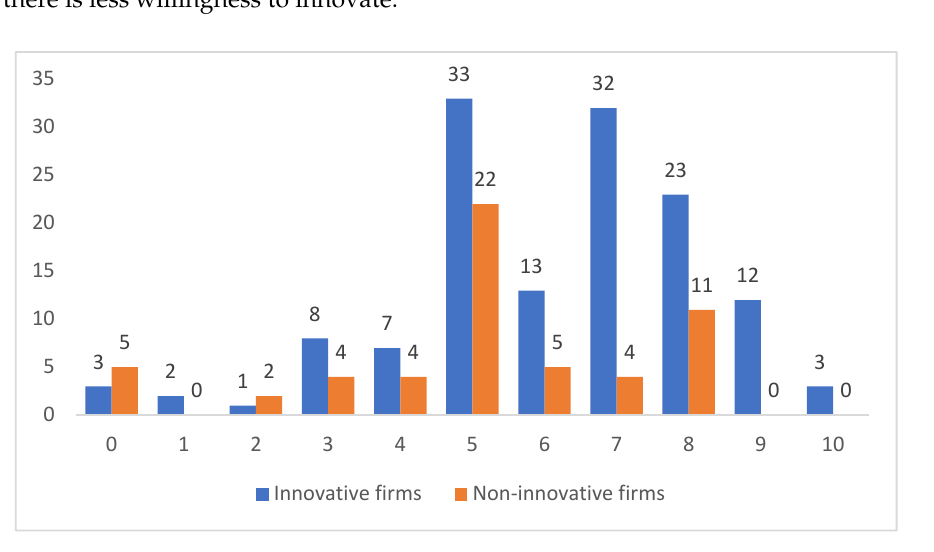
Figure 1. Willingness to innovate and take innovation risks (innovative and non-innovative compa- nies).